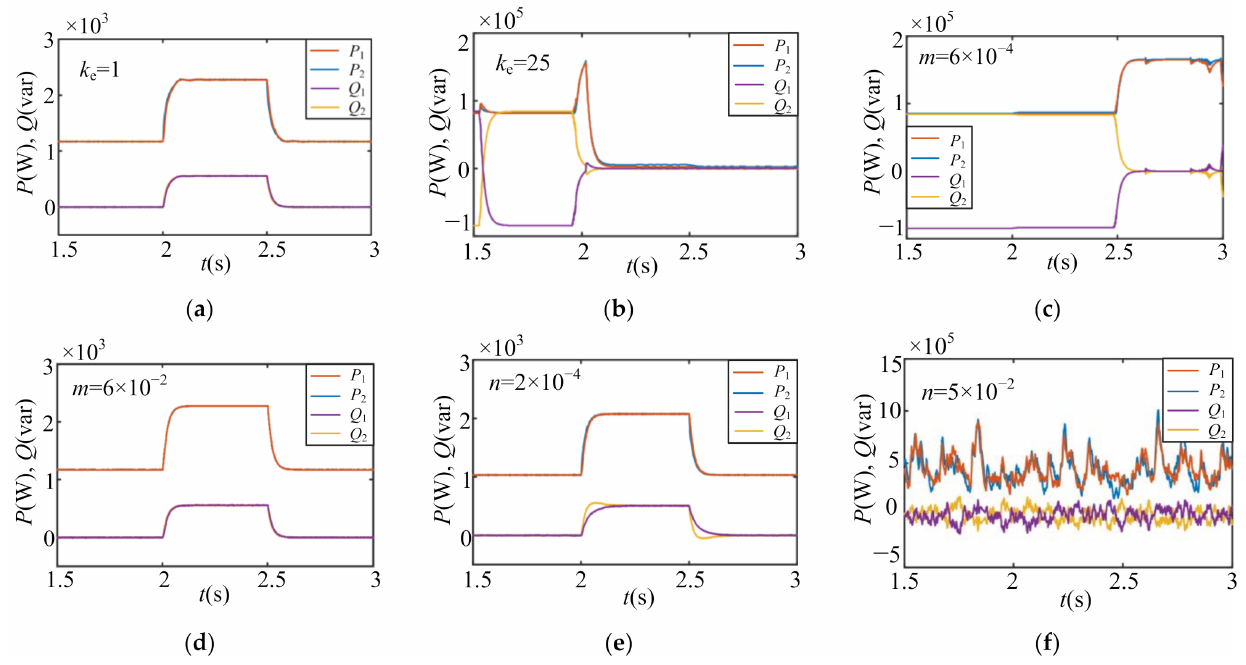
Figure 8. Power response at different parameter values ( k e , m and n ) of proposed TSMC-based P-U/Q-f droop controller: ( a ) k e = 1; ( b ) k e = 25; ( c ) m = 6 × 10 − 4 and n = 2 × 10 − 3 ; ( d ) m = 6 × 10 − 2 and n = 2 × 10 − 3 ; ( e ) m = 6 × 10 − 3 and n = 2 × 10 − 4 ; ( f ) m = 6 × 10 − 3 and n = 5 × 10 − 2